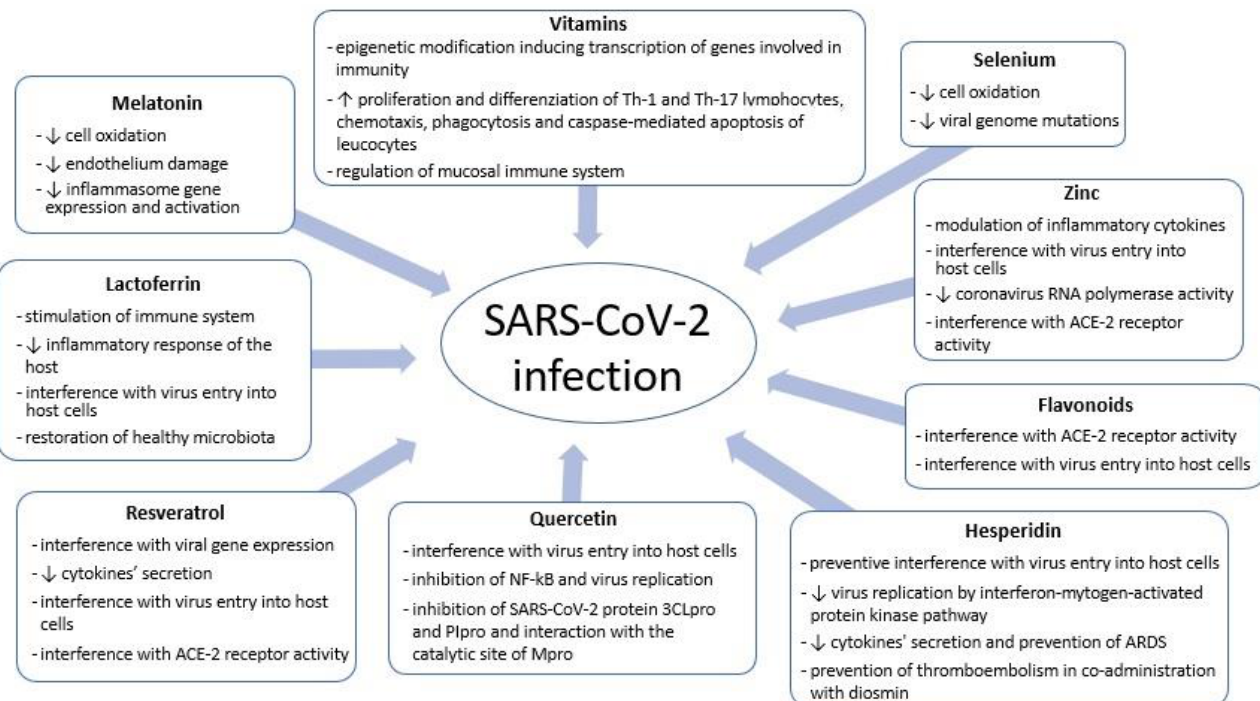
Figure 1. SARS-CoV-2 and antioxidants: mechanisms of interaction between coronavirus 2 and host cells.